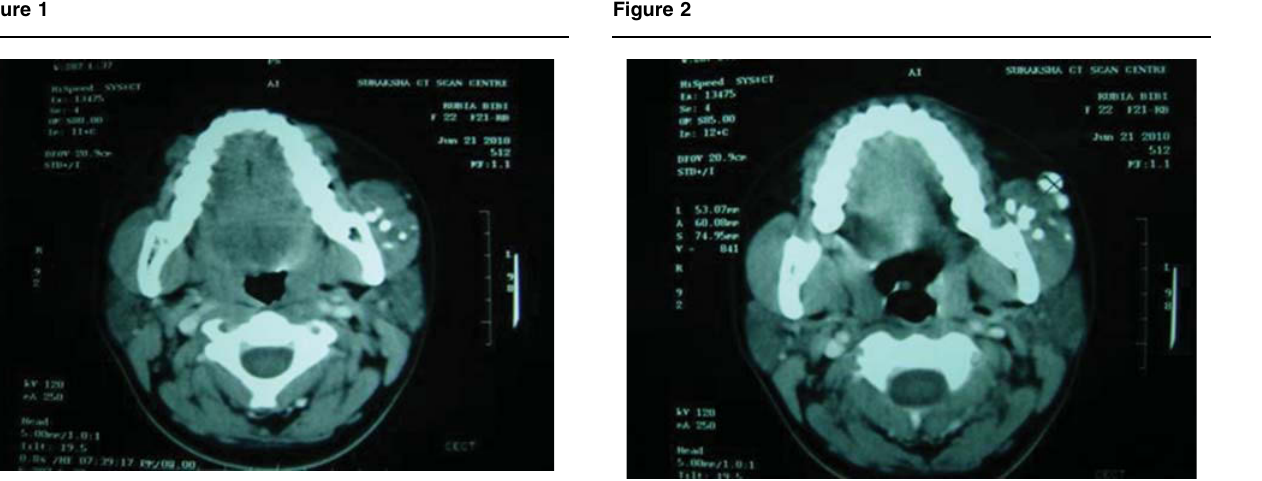
Computed tomography (CT) scan showing multiple parotid calculi in both lobes.